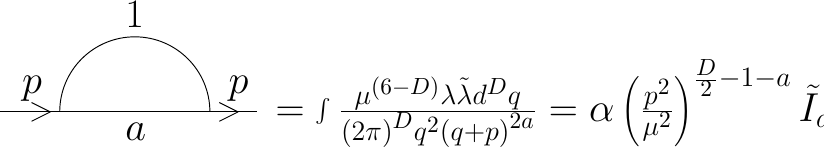
Figure 14 . Elementary building block in the nested sequence depicted in (cid:12)gure 11, and value of its amputated Feynman integral. In this case the iterative factors of the sequence will be proportional to I 2+ k(cid:15)